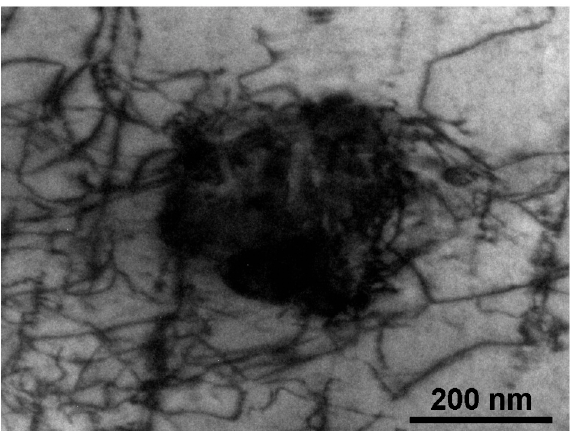
Figure 4. TEM image of dislocations around TiC particles [62].